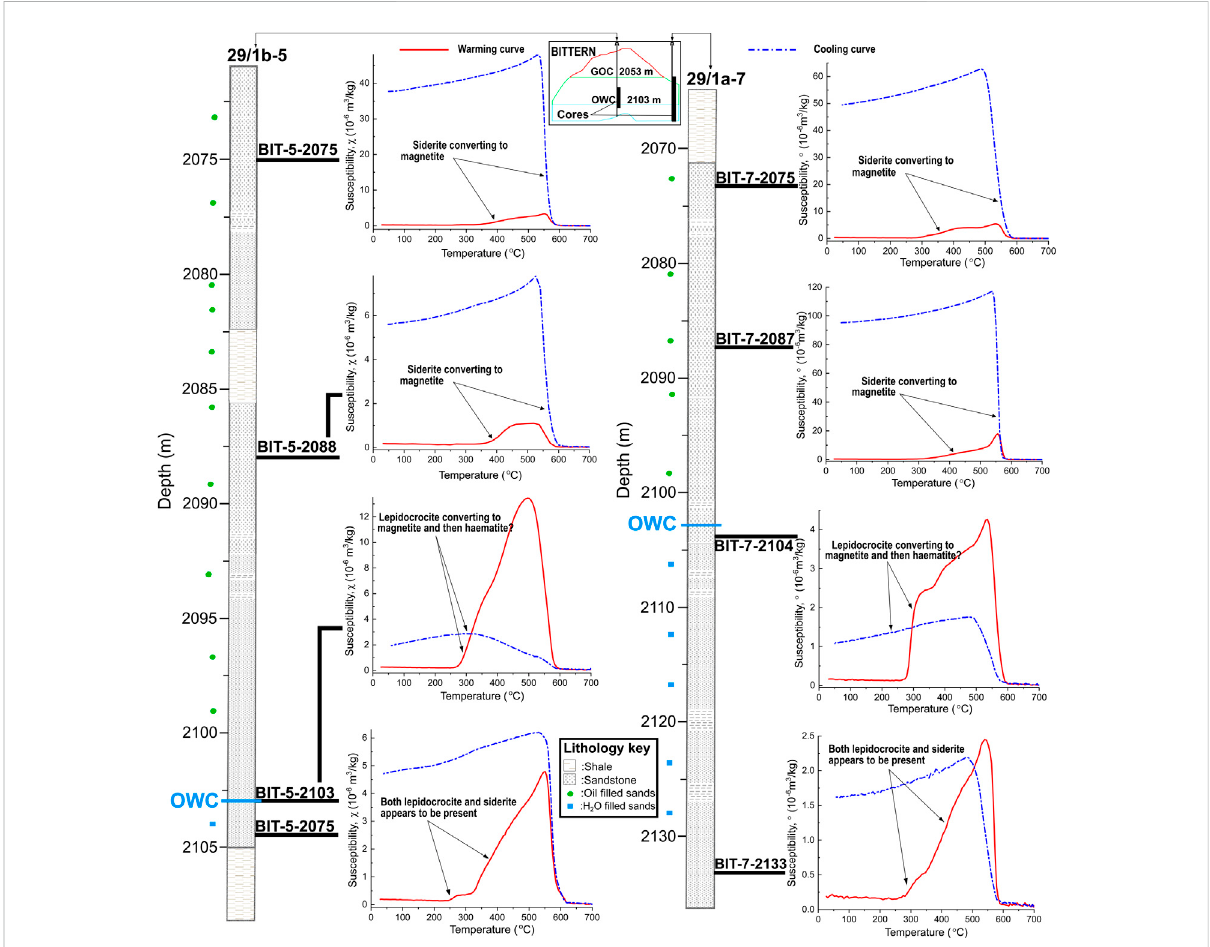
FIGURE 3 ExampleresultsfromtheHT- χ measurementscarriedoutontheBitternsamples.Themagneticminerologyofthe ‘ main ’ oillegisdominatedby siderite. The oil-water contact region contains signi fi cantly less siderite and appears to be dominated by lepidocrocite. The amount of lepidocrocite appears to diminish away from the contact. Note that the OWC highlighted in the fi gure is obtained through well logs and core